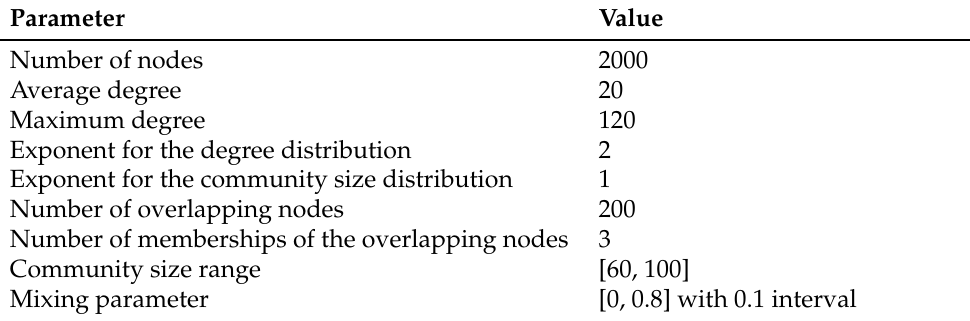
Figure 5. The relative running times of seeding, seed expansion and merging by different local seeding algorithms. Table 9. The parameter settings for the synthetic